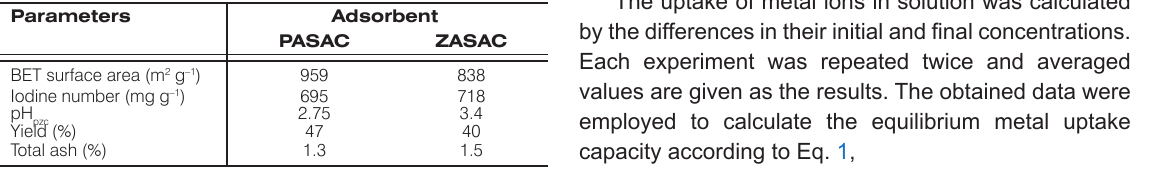
Table 2. Effect of the initial concentration for the adsorption of lead ions onto the PASAC and ZASAC Initial Concentration (mg L –1 )